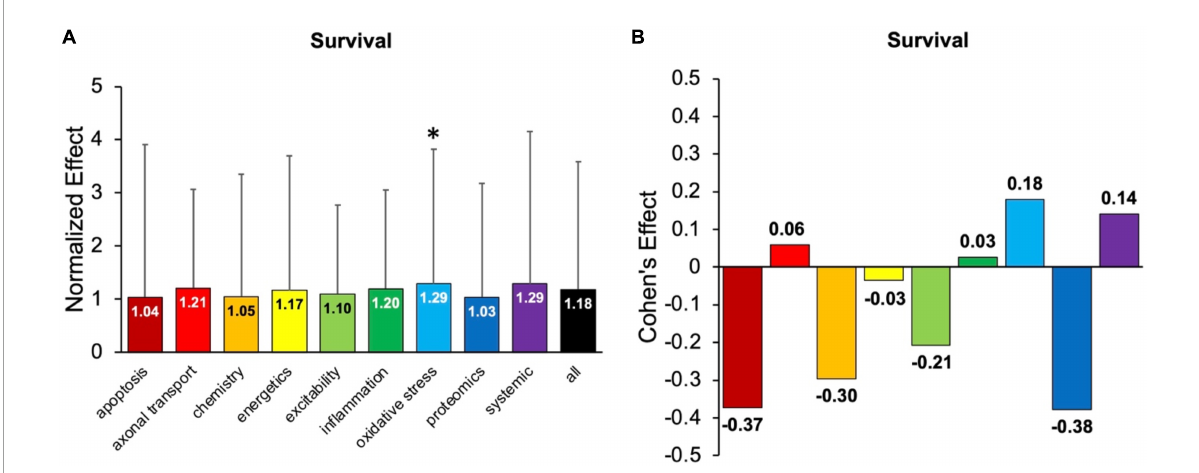
FIGURE5 Assessment of pathophysiological treatment category on survival. (A) Normalized effect size for survival for each pathophysiological treatment category. Error bars represent standard deviation. Each pathophysiological treatment category was compared to the “all” treatments category (black bar) with ∗ denoting a significant difference ( p < 0.05). (B) Calculated Cohen’s effect size of survival for each pathophysiological treatment category. Cohen’s effect is a statistical measure of each pathophysiological treatment category’s effect size on survival relative to “all” treatments (e.g., all pathophysiological treatment categories